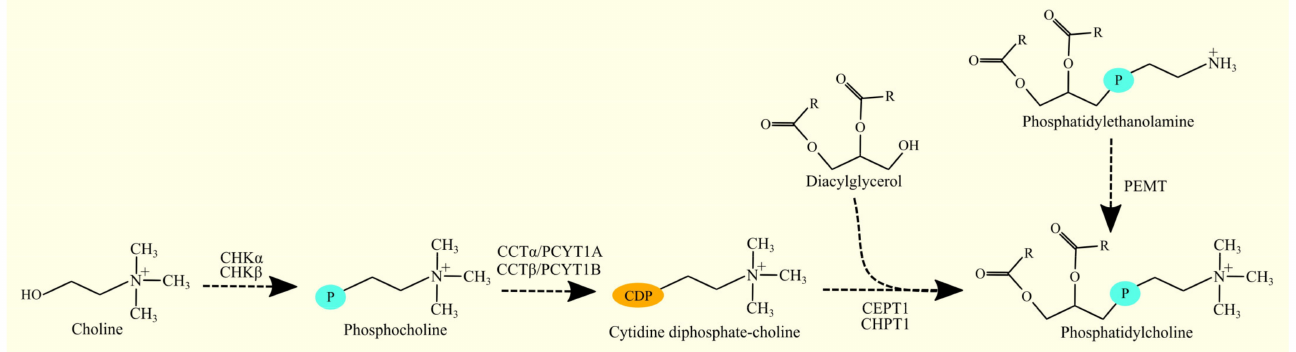
Figure 7. Biosynthesis of PC. The biosynthesis of PC occurs in the Kennedy pathway. In this pathway, choline is phosphorylated and then converted to CDP-choline. In the final step, CDP-choline reacts with DAG to produce PC. The enzymes responsible for these reactions are CEPT1 and CHPT1. PE and PC can undergo further transformations. Ethanolamine in PE can be methylated by PEMT to form PC from